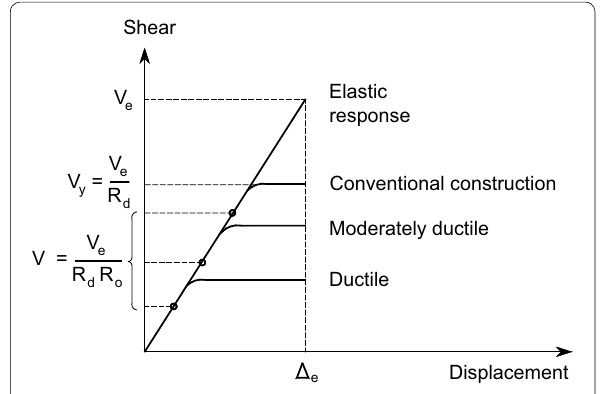
Fig. 1 Seismic force reduction for different levels of